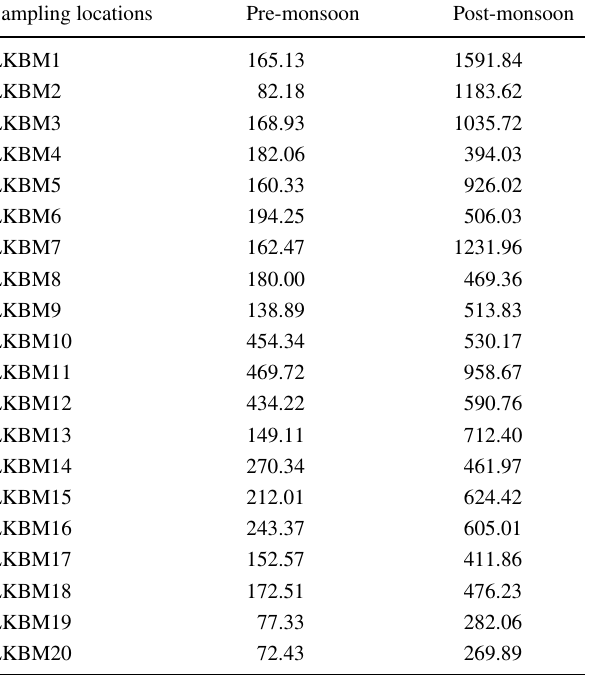
Table 8 EHCI in sampling locations at North Guwahati Sampling locations